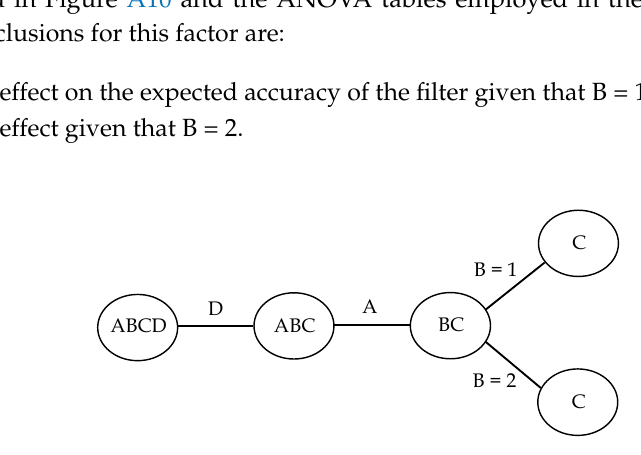
Figure A10. Tree graph for the analysis of the effect of factor C on the expected accuracy